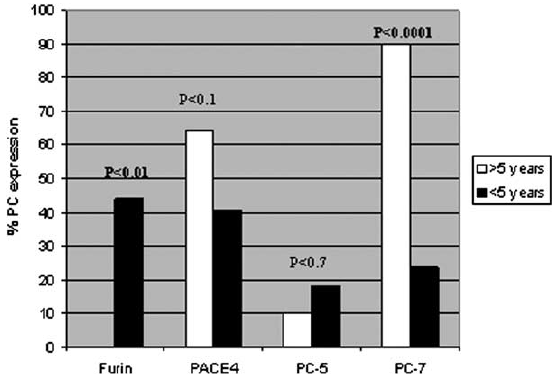
Fig. 3. PC’s expression in tumors and survival time. DNAase-treated RNA from surgical specimens was amplified by RT-PCR. The ex- pression of the ubiquitous expressed PCs (furin, PC4, PC-5 and PC-7) was analyzed in tumors from patients that survived longer ( n = 11) and less ( n = 37) than 5 years. The results are expressed as percentage of cases that showed the corresponding band. Signifi- cance was studied applying the Fisher exact tests. Note that furin is exclusively expressed in the group that survived less than five years. Conversely, PC-7 expression was significatively higher in the group that survived more than five